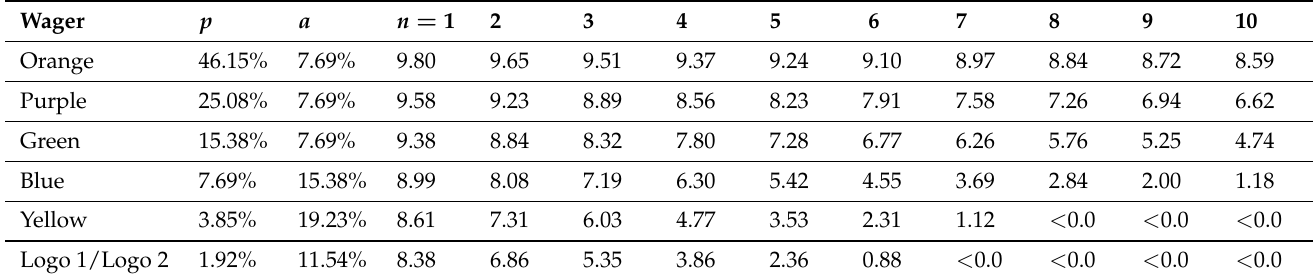
Table 7. Proposed ROR scales for the Big